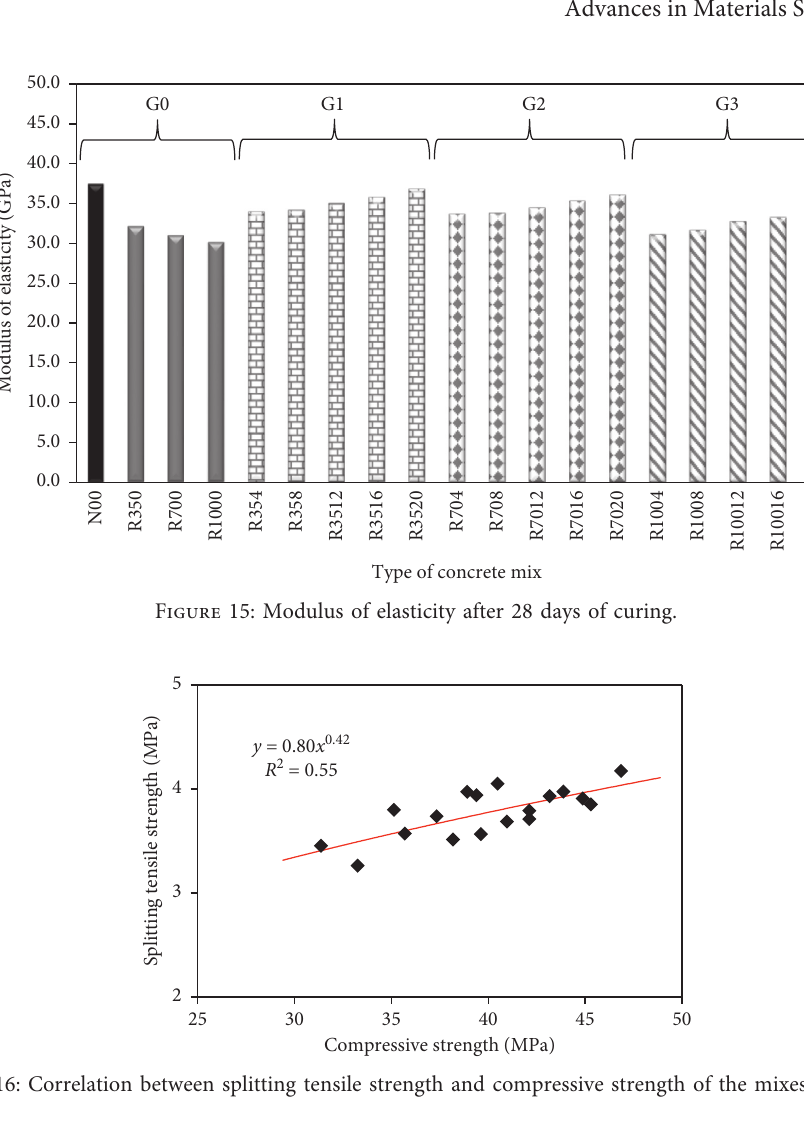
y = 0.49 x 0.61 R 2 = 0.71